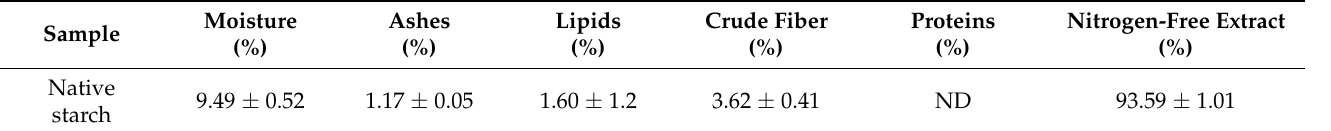
Table 1. Mean ± standard deviation of the proximal composition of native starch from Talisia floresii Standl